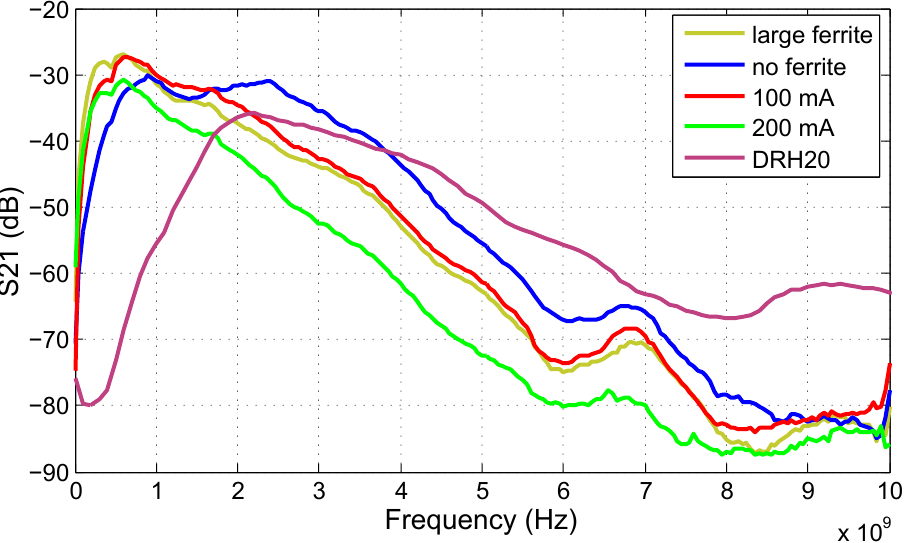
Figure 22. Transmission coe ffi cient of the proposed LCR antenna measured under multiple di ff erent conditions: yellow—with larger absorbers, blue—without absorber, red—100 mA output stage current, green—200 mA output stage current. Professional antenna DRH20 measured for comparison